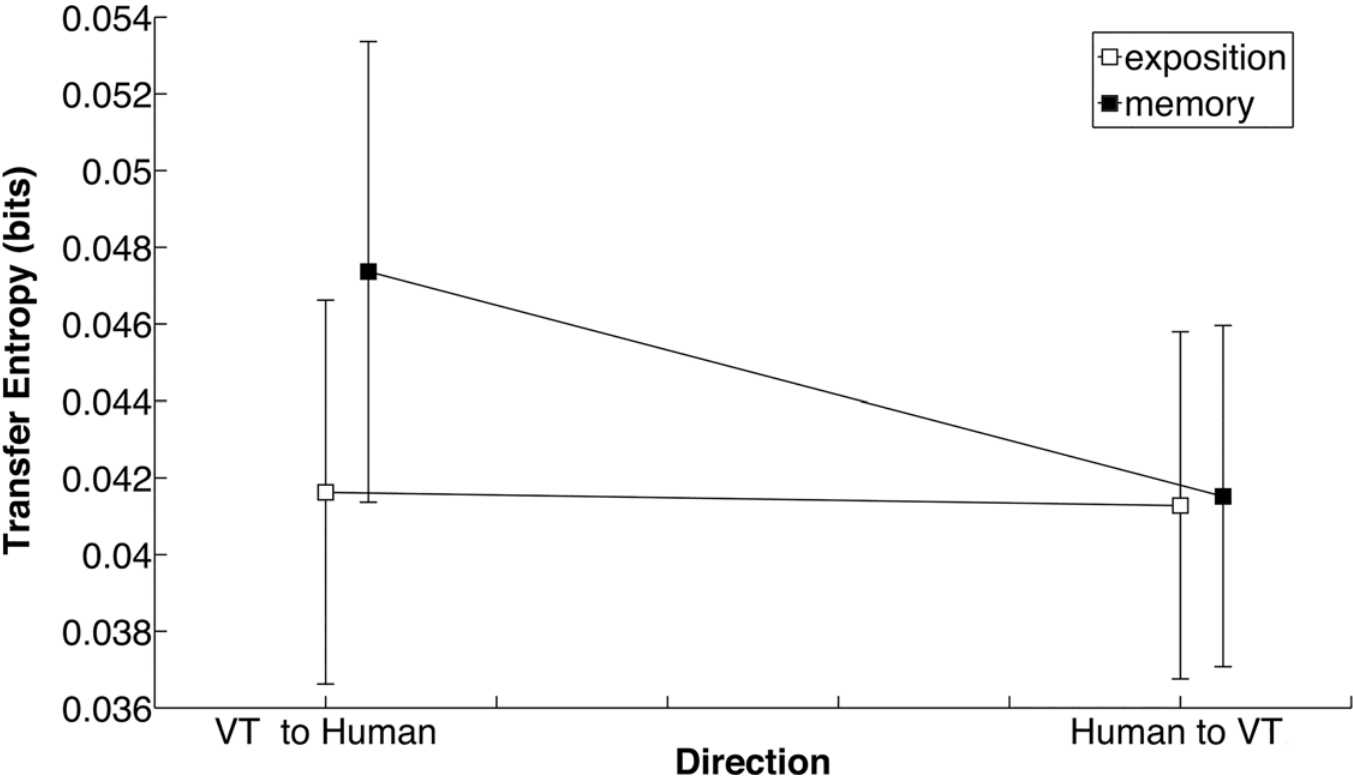
Fig 9. Information exchange during practice. Transfer entropy from VT to human and from human to VT at Exposition (open boxes) and at Memory (filled boxes).